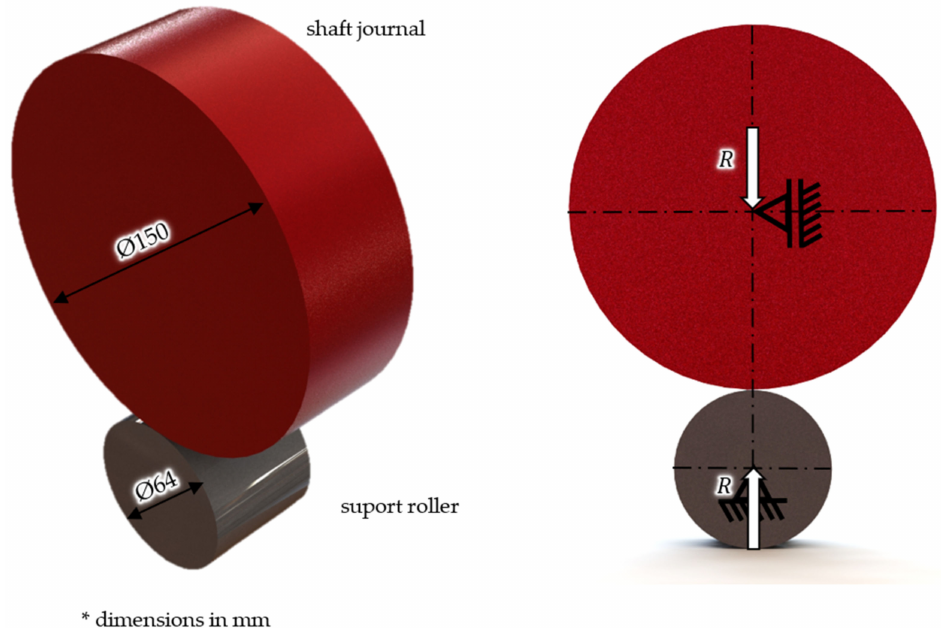
Figure 4. The cooperation model adopted for the analysis of surface pressures and stresses at the contact point of the rolling prism roller with the main shaft